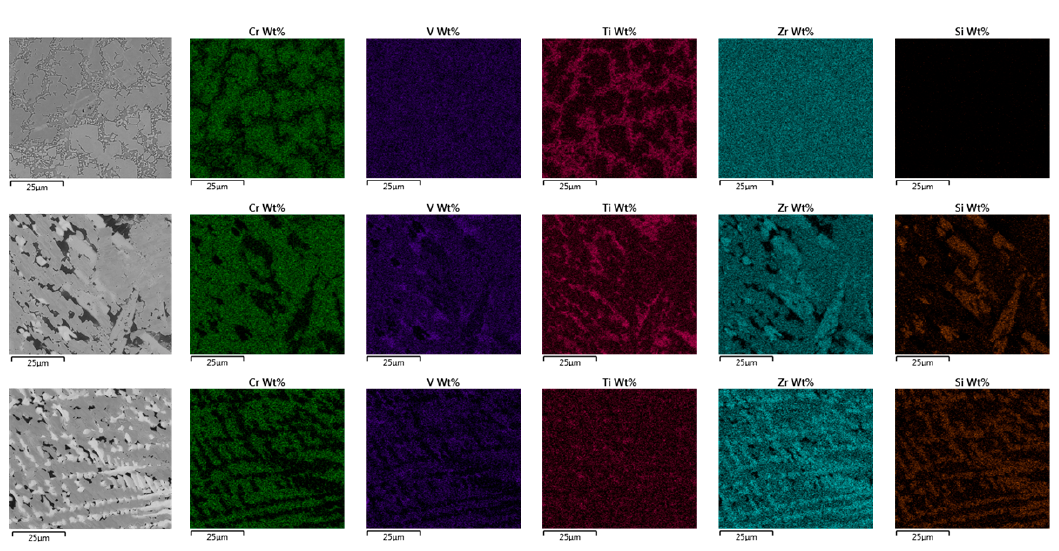
Figure 5. Energy-dispersive X-ray spectroscopy (EDS) maps for TiVCrZr-Si x alloys showing the distribution of each element (the top row shows maps for x = 0, the middle row shows maps for x = 0.5, and the bottom row shows maps for x = 1.0). Table 1. Summary of the phases and the elements concentrated in (+) or depleted from ( − ) them, or close to the expected level (~) relative to the overall composition for each of the alloys studied, as observed in the EDS results.